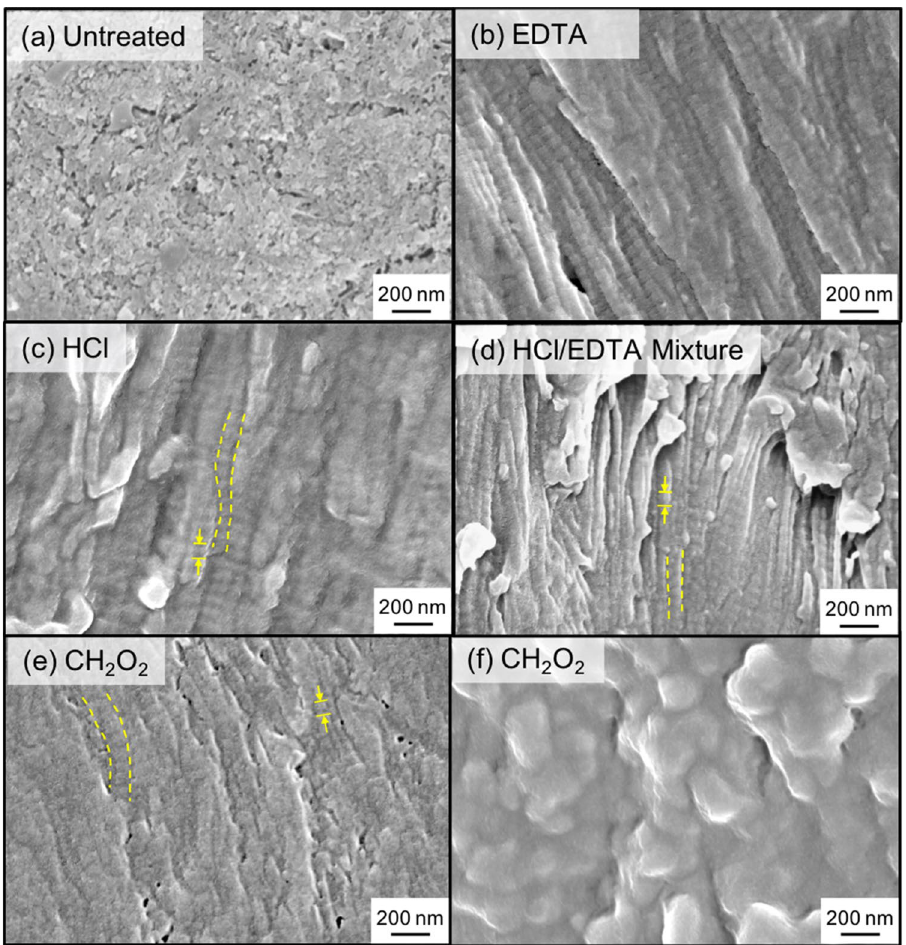
and (e,f) formic acid (CH 2 O 2 ). Visible collagen fibrils are outlined in yellow, dotted lines and d -spacing are indicated by